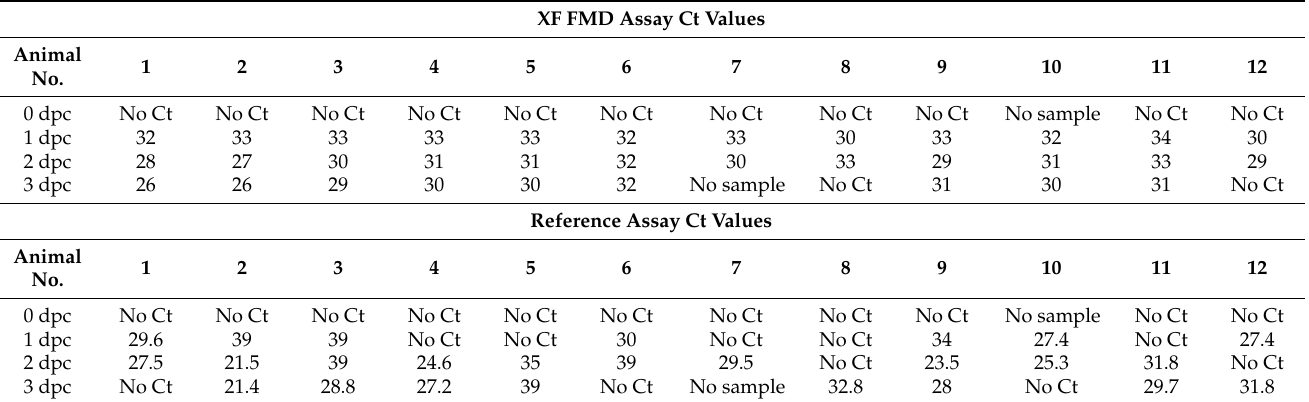
Table 3. The Ct values obtained for the XF FMD assay and the reference assay for the time course experiment for the 12 infected animals at 0 dpc to 3 dpc. No Ct indicates that no amplification occurred for a given time